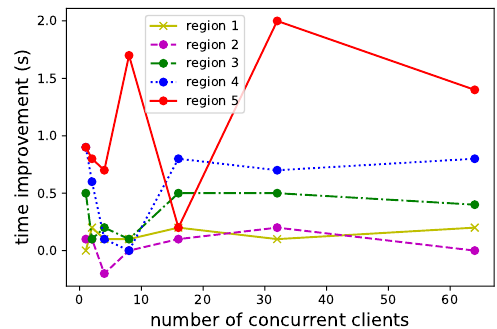
Figure 7. Scenario 1: 64 threads in thread pool